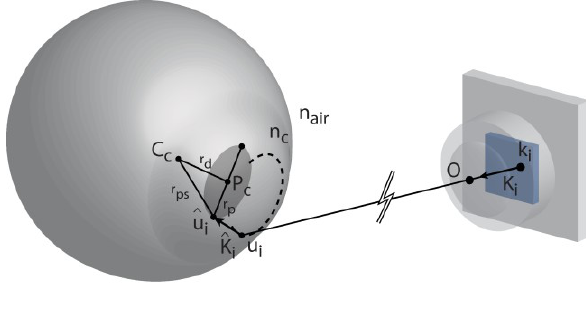
Figure 5. The ray tracing method for estimating the pupil center. P c is the pupil center, C c is the cornea center, û i is a point in the pupil perimeter, u i is a point in the corneal surface, K̂ i is a unit vector between these, k i is the image point of u i , K i is the unit vector between these, and O de- notes the optical center. The ray K i refracts at the cor- neal surface because the refractive index of the cornea is n c > 1. The figure is adapted from Hennessey et al. (2006).